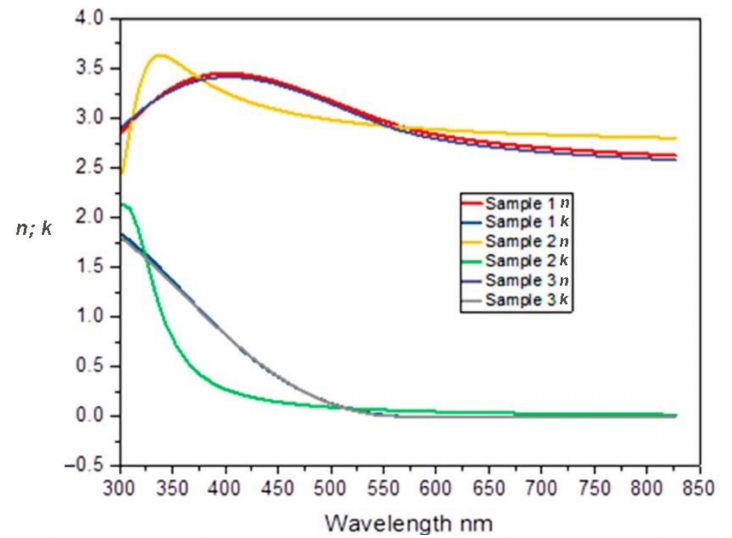
Figure 8. Graphs of n and k coefficients for Samples 1, 2, and 3 of Cu 2 O:N thin films; λ is wave- length